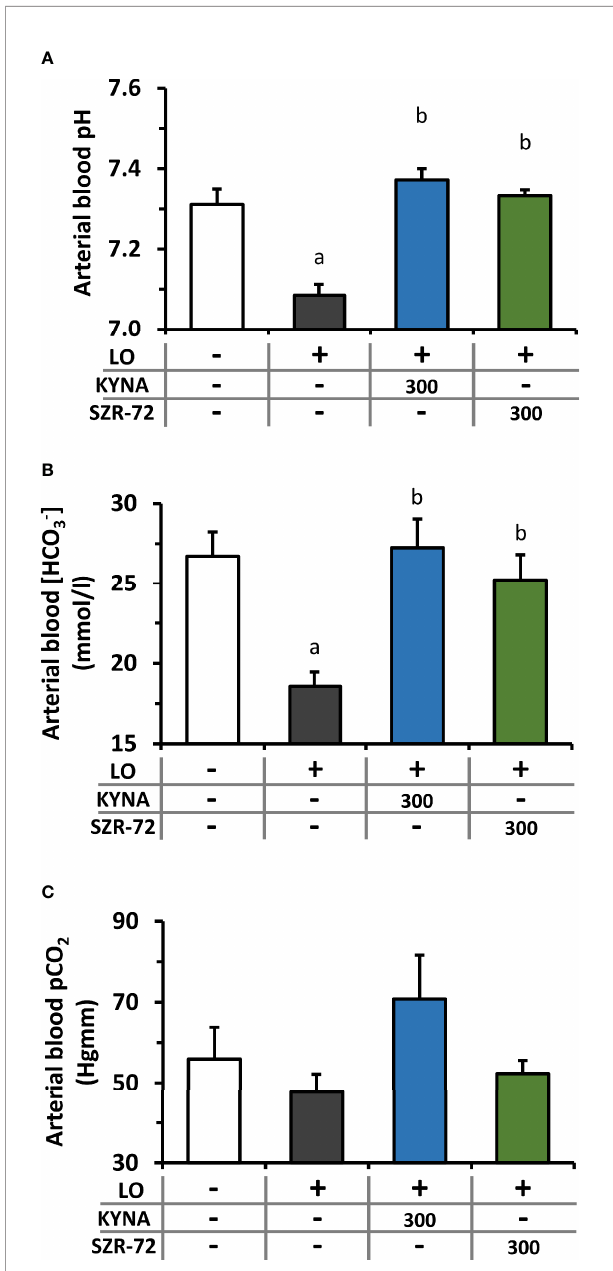
FIGURE 5 | Plasma pH and HCO 3- and pCO 2 levels during experimental AP and treatments with KYNA and SZR-72. Bar charts show (A) arterial blood pH, (B) arterial blood HCO 3- concentration, and (C) arterial blood CO 2 pressure. Values represent means with standard error, n=3-6. One-way ANOVA was performed followed by Holm-Sidak post-hoc test. Statistically signi fi cant differences (p<0.05) were marked with: (a) vs . control; (b) vs . LO. LO, L-ornithine-HCl.